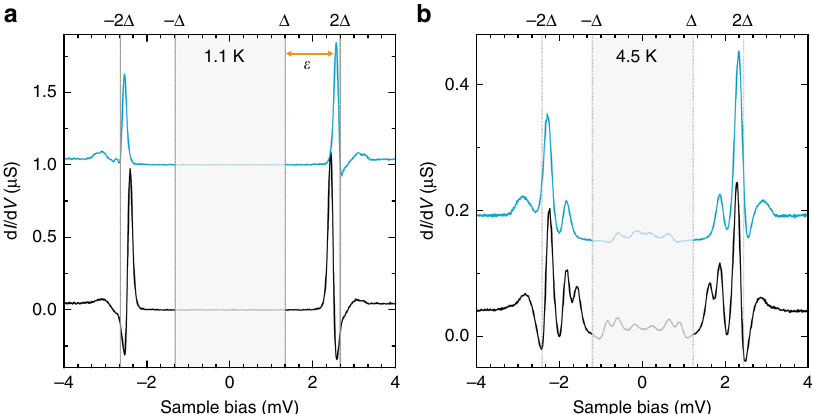
Fig. 2 YSR excitations at different temperatures. Two typical spectra of MnPc – NH 3 at 1.1 K ( a ) and 4.5 K ( b ), respectively, acquired with a superconducting Pb tip (5 mV, 200 pA, 20 μ V rms ). Gray-shaded areas indicate sample biases eV j j (cid:3) Δ tip . At 4.5 K ( b ), additional resonances are observed because of tunneling out off/into thermally excited